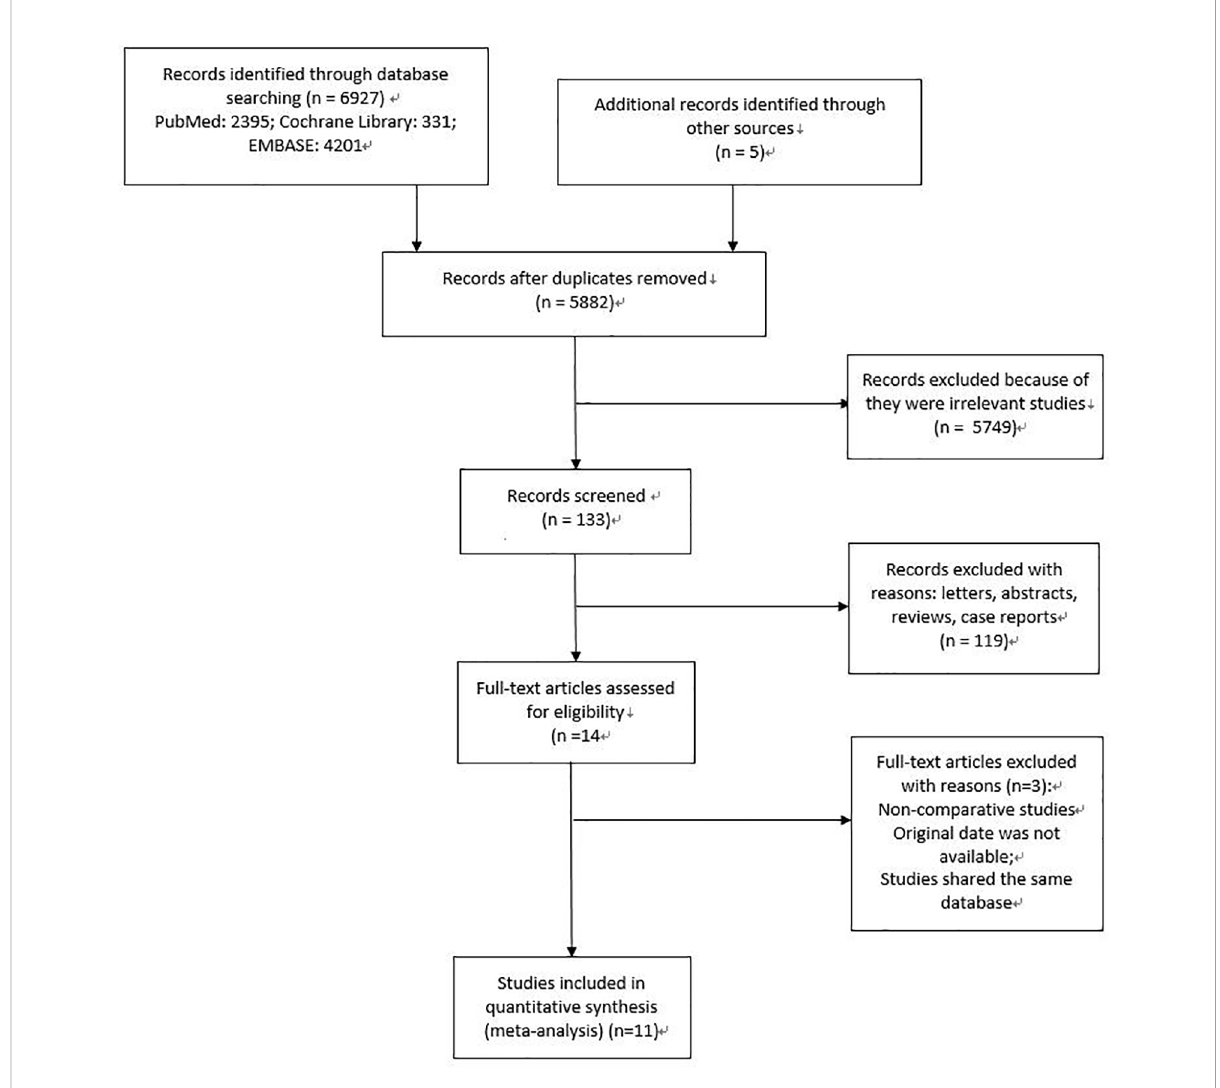
FIGURE 1 The speci fi c process of literature research and